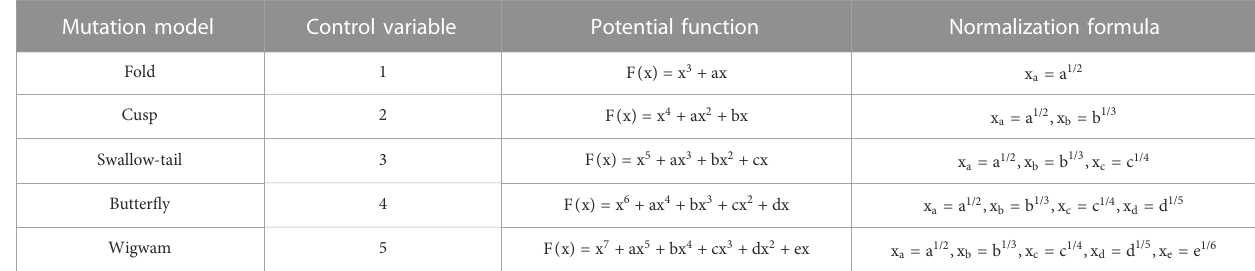
TABLE 1 Common mutation models. Mutation